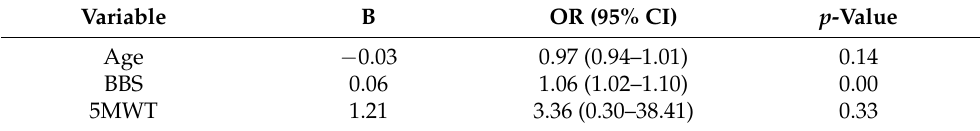
Table 2. Multivariate logistic regression model to predict community ambulation at discharge.